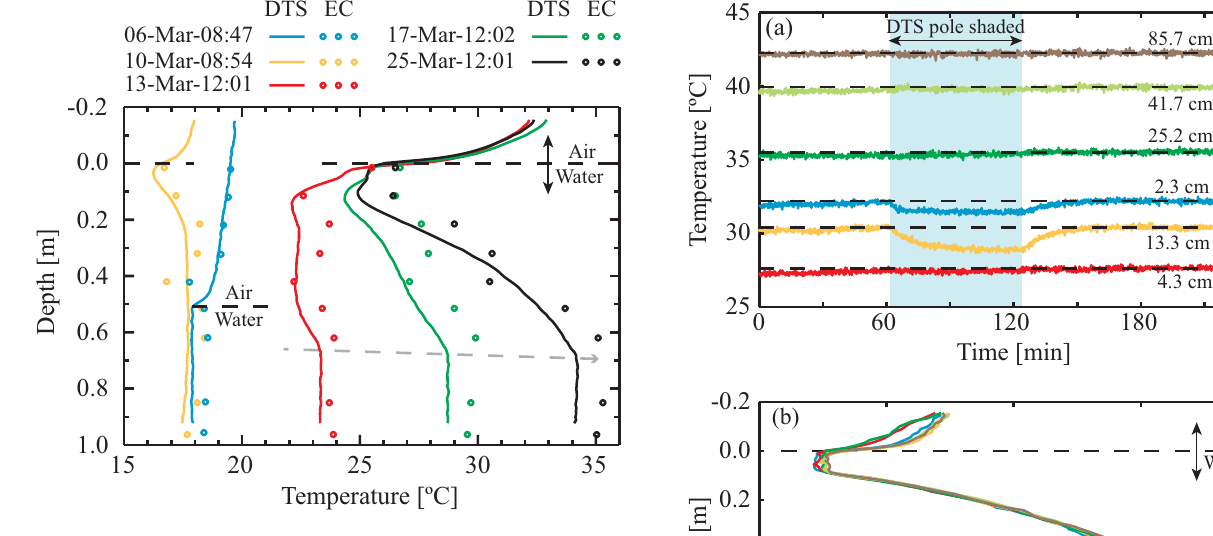
Fig. 5. Comparison of the temperature profile measured with the DTS system and with electrical conductivity (EC) probes. In the morning of 6 March the solar pond was filled to a depth of 0.50m. These measurements were obtained using the manufacturer-internal calibration method.